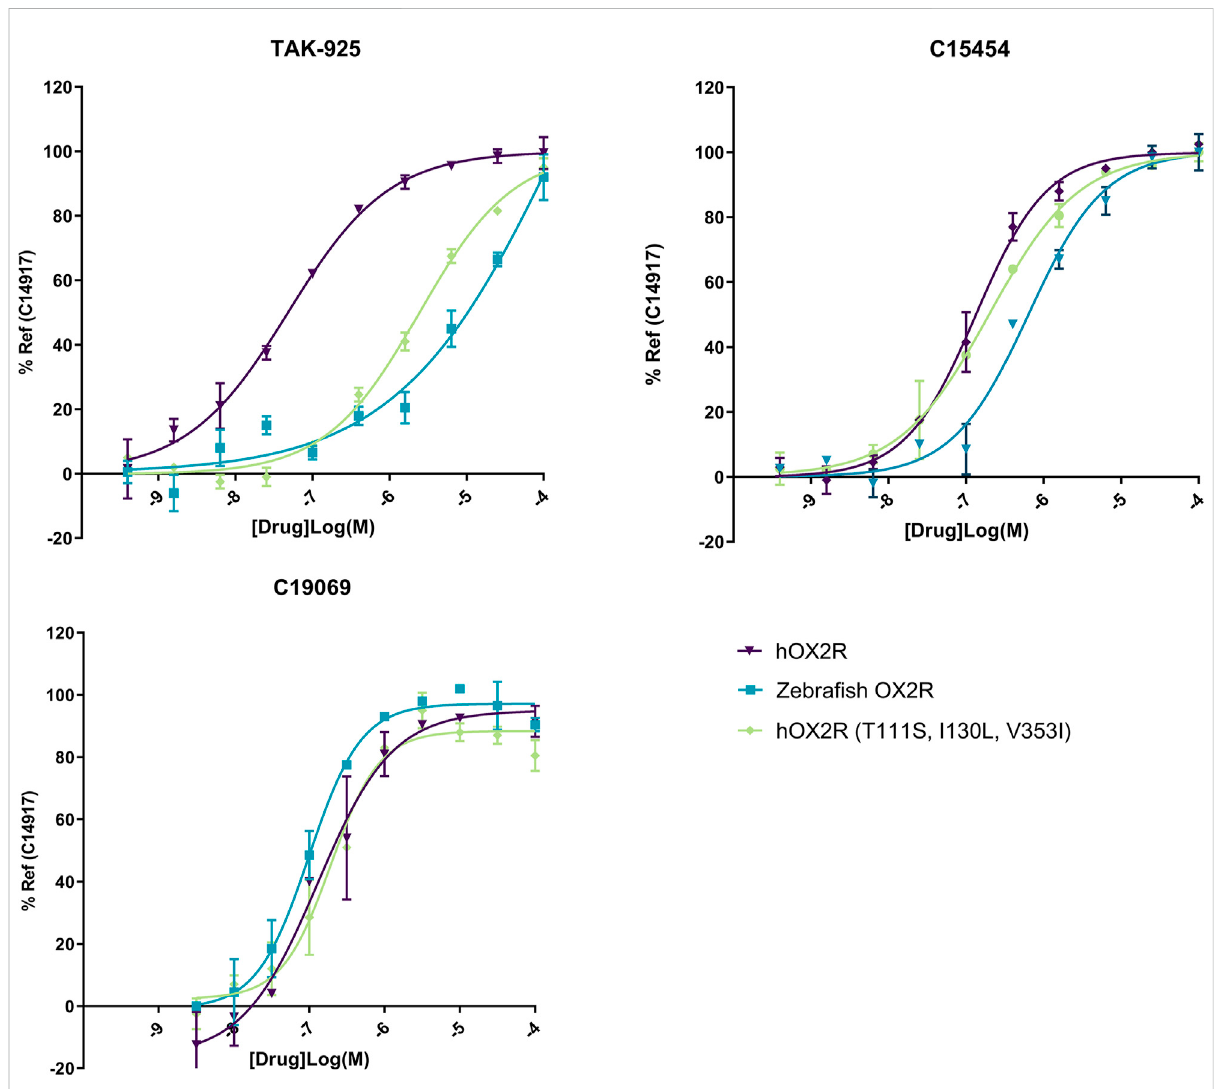
FIGURE 3 Representative IP-One dose response curves for agonists TAK-925, C15454 and C19069 on human OX2R (purple), zebra fi sh OX2R (blue) and hOX2R (T111S, I130L, V353I) (green). Cells were incubated for 1 h with agonist and subsequently readout was performed. Dose responses were performed as technical duplicates, data were normalized to 10 µM of reference agonist